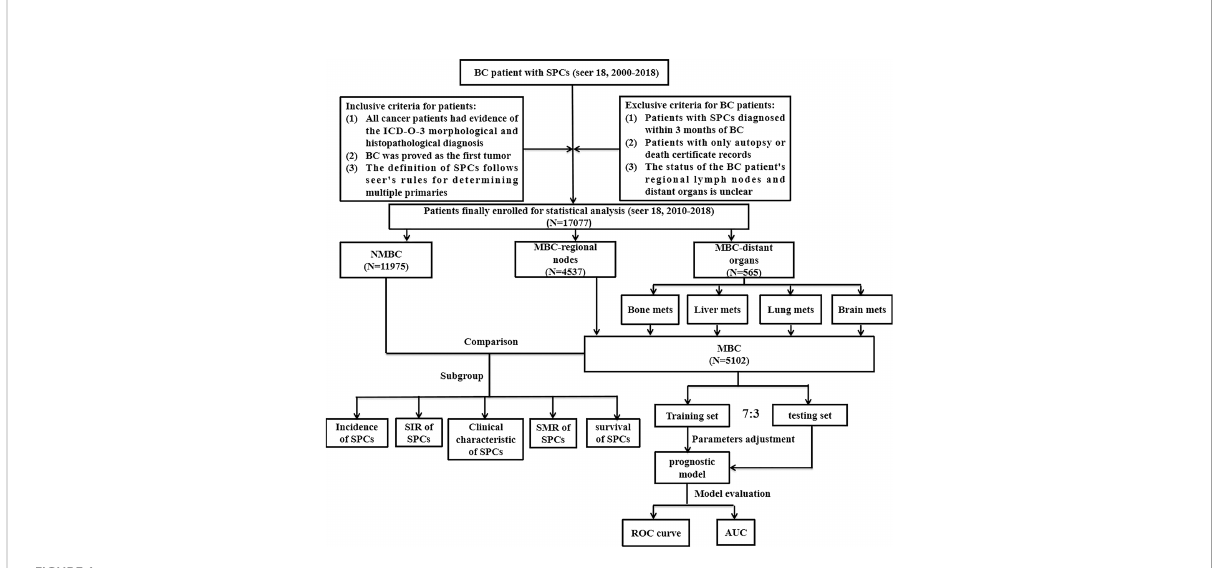
FIGURE 1 The fl owchart shows the process of conducting the study and statistical